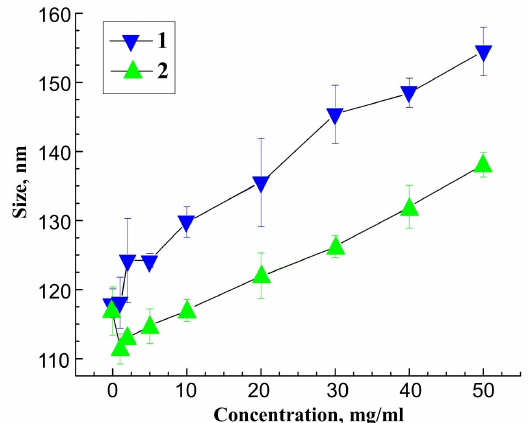
Figure 6. Hydrodynamic size of associates of quartz NPs + native BSA 5fr (1) and of NPs ShC + native BSA 5fr (2) in a dispersion based on 0.2 M phosphate-buffer solution (pH 5.2) at 25 ◦ C plotted against protein concentration. ShC concentration 0.025 mg/mL and Qz NP concentration 0.67 mg/mL.